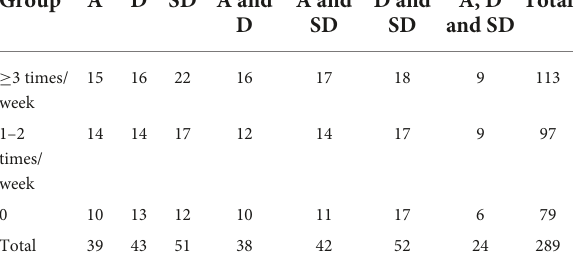
TABLE 1 Different self-practice in people with anxiety, depression and sleep disorders.